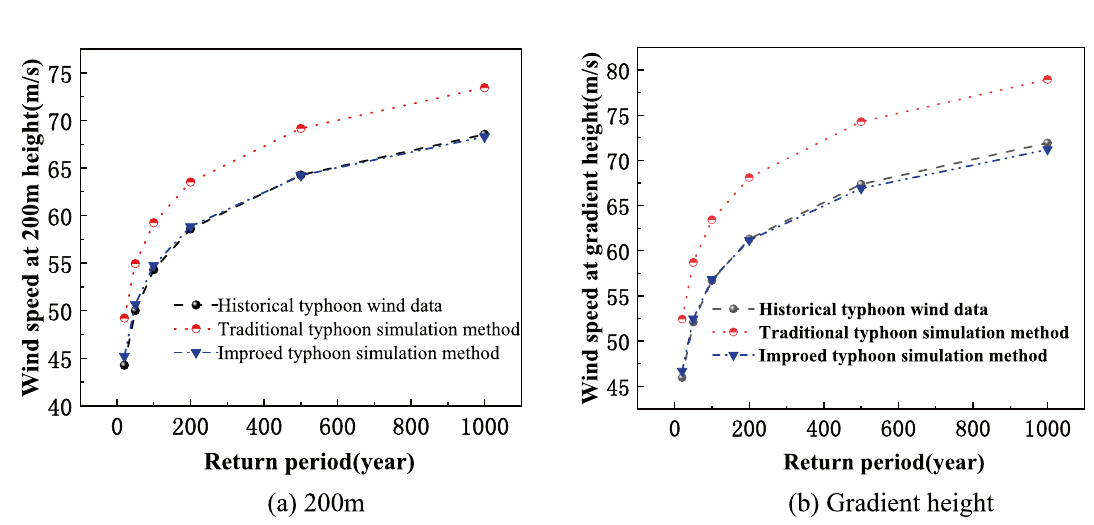
Figure 2. Comparison of typhoon extreme wind speeds under different return